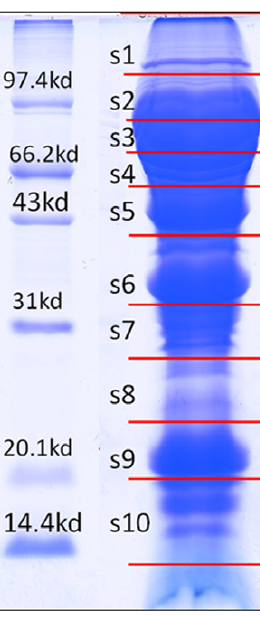
Figure 2. SDS-PAGE gel image of the germinating soybean seeds. 12% gel was used, and 4 ug of marker proteins were loaded. The s1–s10 indicate the 10 slices that were cut for in-gel digestion.